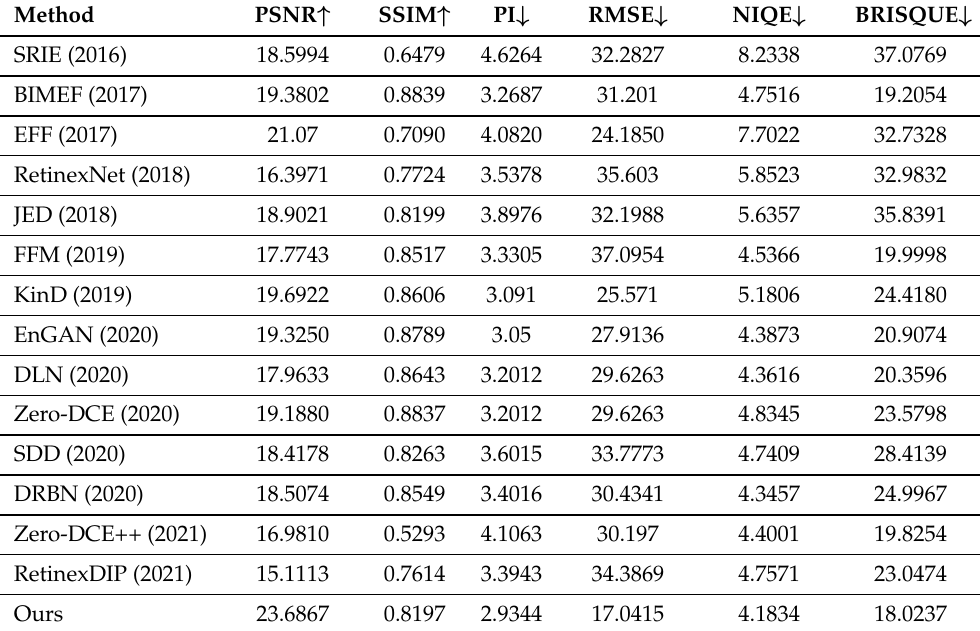
Table 5. Objective evaluation results of the six metrics PSNR, SSIM, PI, RMSE, NIQE, and BRISQUE for the MIT [32]